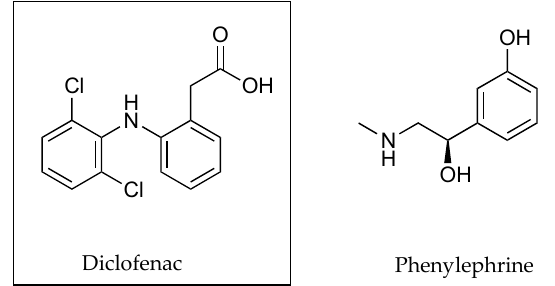
Figure 17. DIC and phenylephrine counter ion.